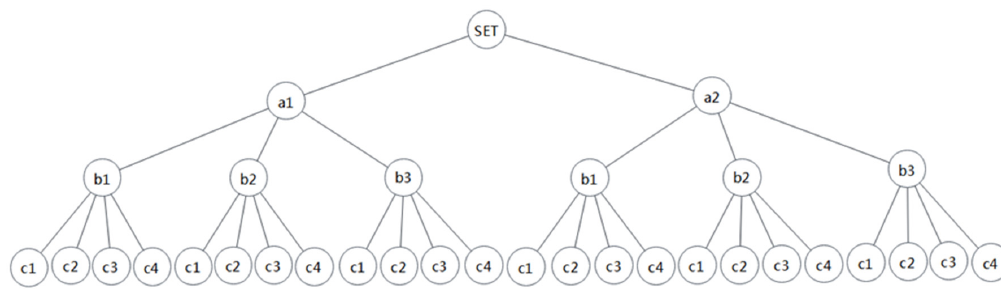
Figure 2. An example of a policy decision tree.